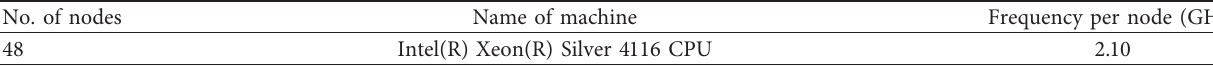
Table 2: Working environment.